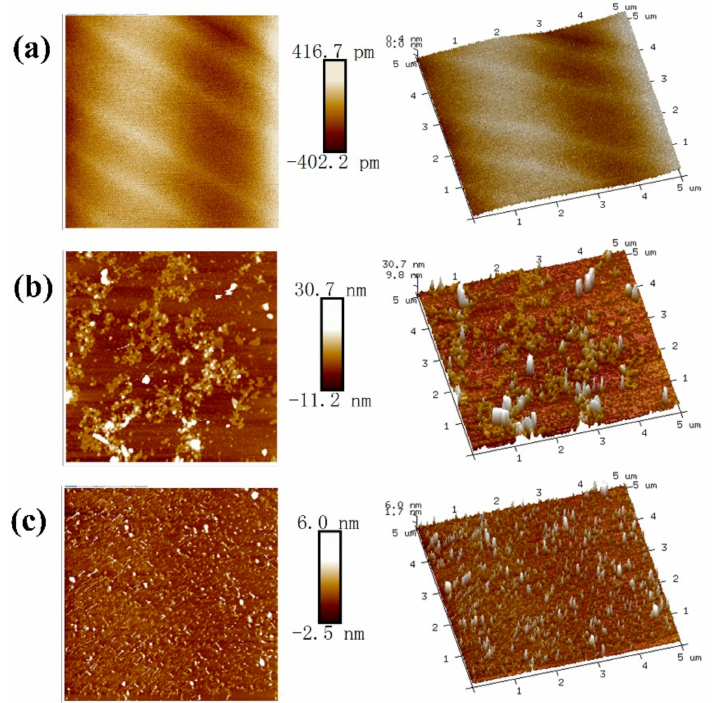
Figure 12. Typical 2D and 3D AFM images (5 µ m × 5 µ m) of: ( a ) untreated MoS 2 ; and MoS 2 treated in: ( b ) 0.05 M MgCl 2 ; and ( c ) 0.05 M MgCl 2 with 50 mg/L SHMP at pH of